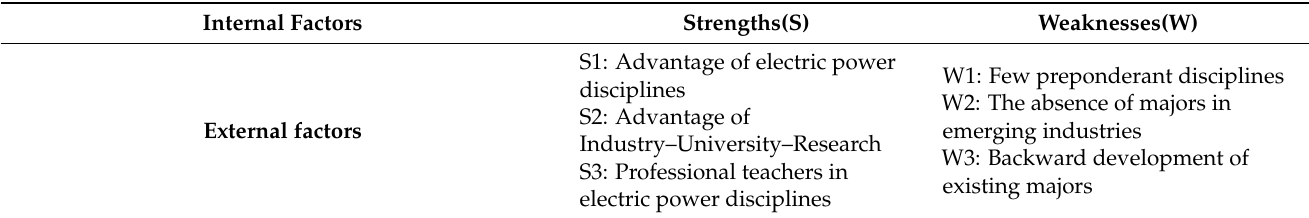
Table A3. SWOT matrix of specialty structure optimization of the universities or faculties featuring electric